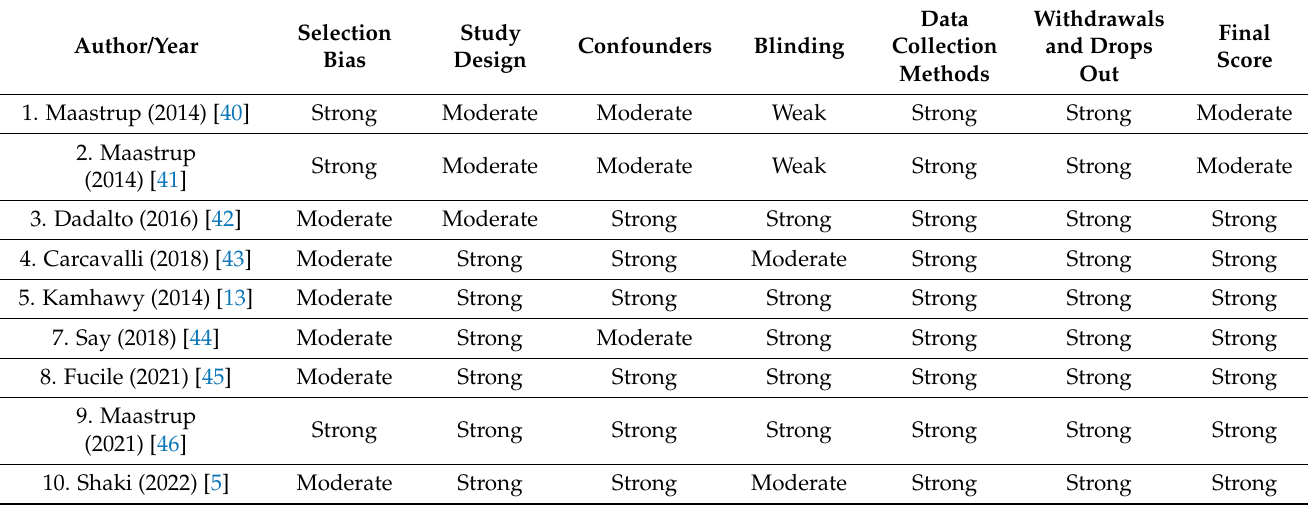
Table 1. Methodological Quality of the Studies according to Quality Assessment Tool for Quantitative Studies